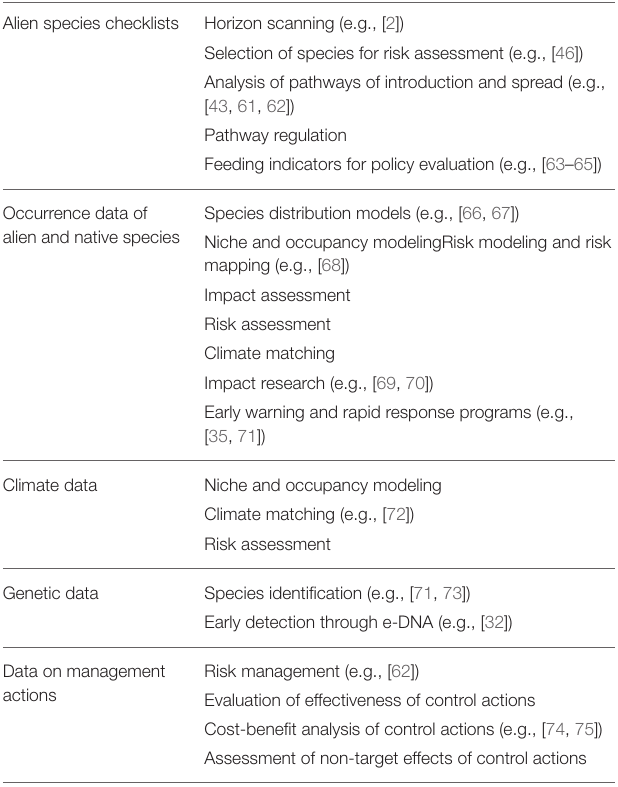
TABLE 1 | Data/information categories and their invasive alien species-related evidence-based processes. Alien species checklists Horizon scanning (e.g., [2]) Selection of species for risk assessment (e.g., [46]) Analysis of pathways of introduction and spread (e.g., [43, 61, 62]) Pathway regulation Feeding indicators for policy evaluation (e.g., [63–65]) Occurrence data of Species distribution models (e.g., [66, 67]) alien and native species Niche and occupancy modelingRisk modeling and risk mapping (e.g., [